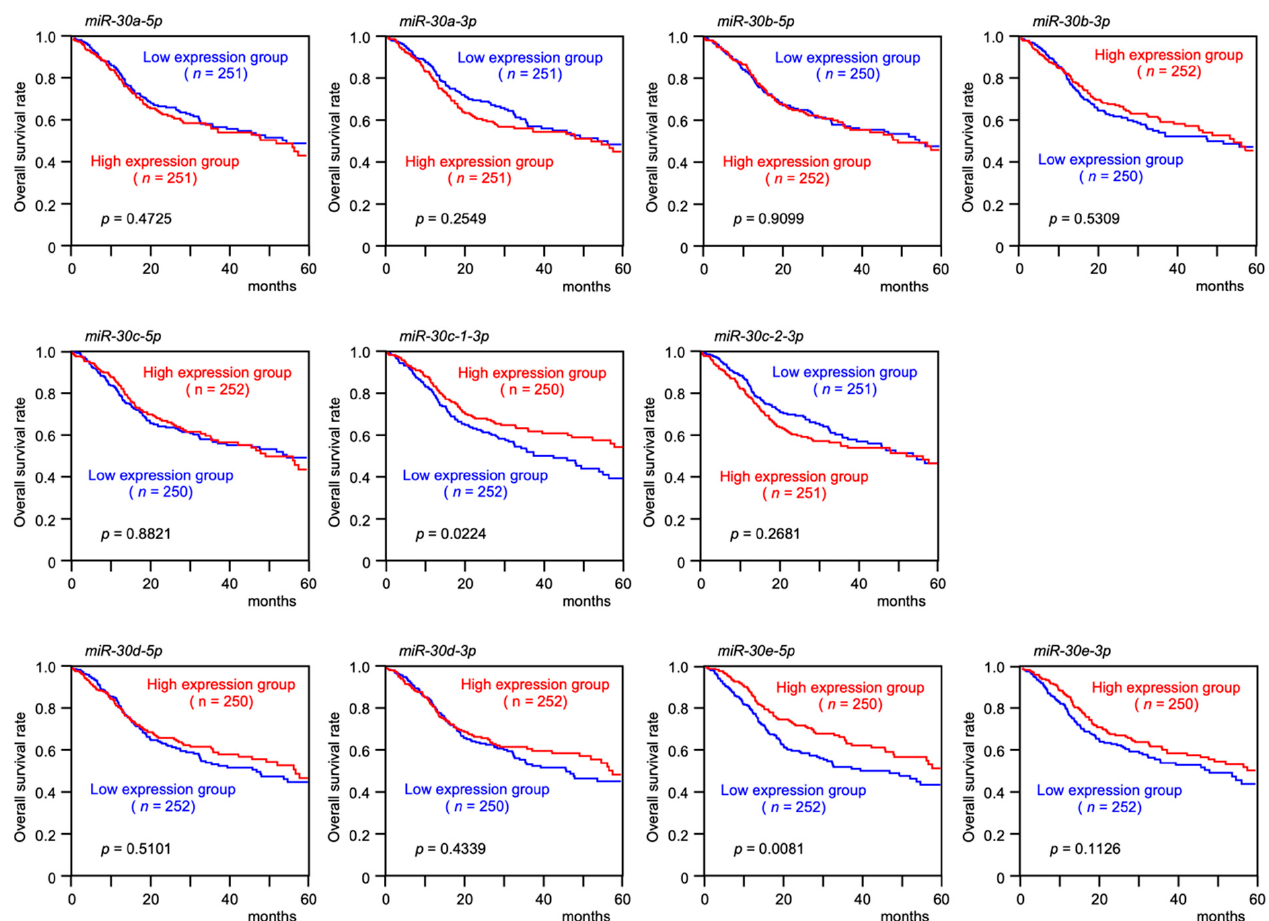
Figure 3. Kaplan–Meier survival analyses of HNSCC patients using data from TCGA-HNSC. Patients were divided into two groups according to the median miRNA expression level: high and low expression groups. The red and blue lines represent the high and low expression groups, respectively.